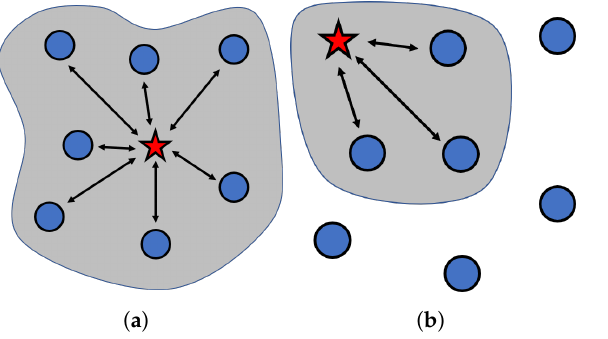
Figure 3. Reference choice impact over the family construction. ( a ) Good reference choice, ( b ) bad reference